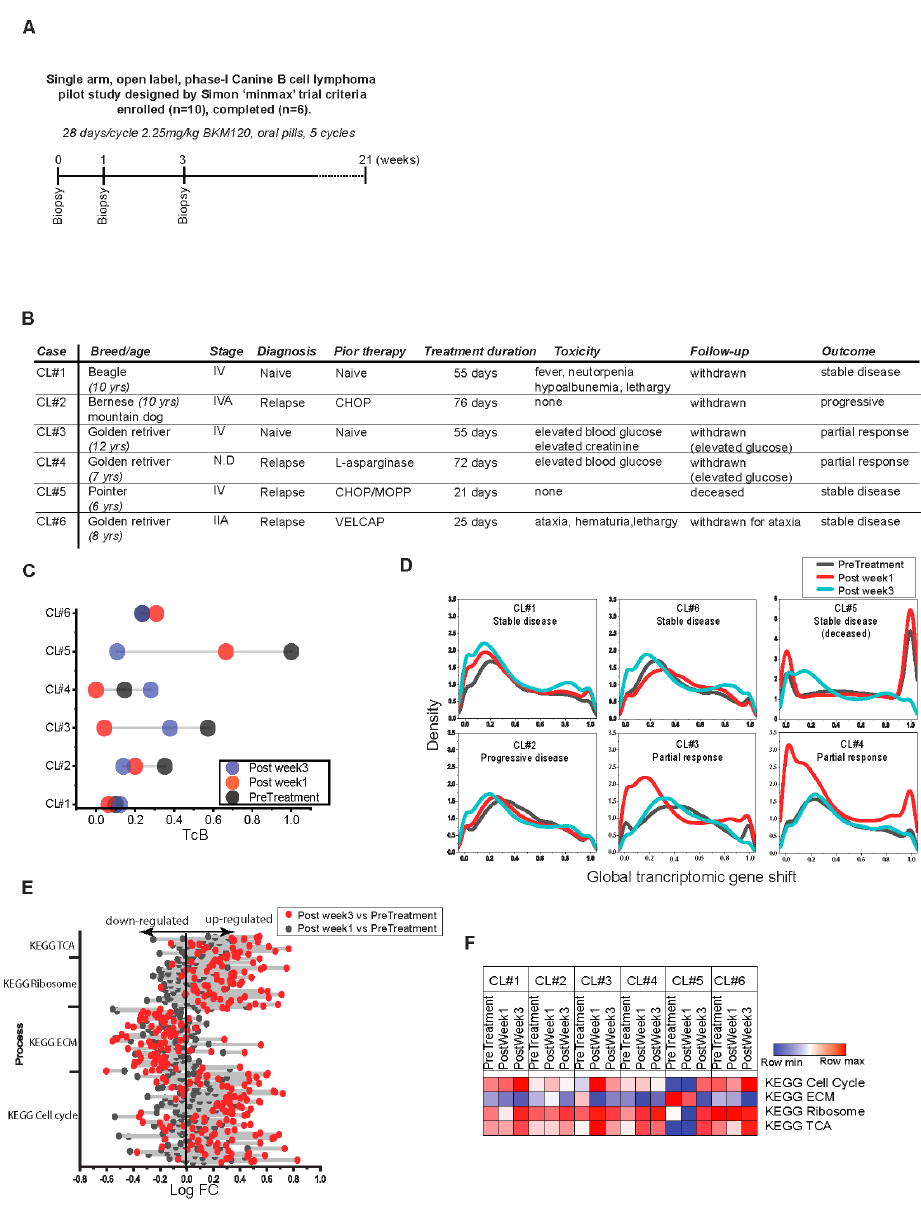
Figure 6. Targeted therapy impacts the biological trajectory of canine lymphoma. ( A ) Schematic illustration of BKM120 canine lymphoma clinical trial design. ( B ) Clinical characteristics of canine lymphoma trial subjects including clinical stage, diagnosis, prior therapies (CHOP-cyclophosphamide, hydroxydaunorubcin, oncovin/vincristine, and prednisone; MOPP-mechlorethamine hydrochloride, oncovin, adriamycin/doxorubicin, vincristine, L-asparginase), and treatment durations. ( C Lollipop plot displaying TcB change by pre-treatment and BKM120 treatment intervals on x-axis with canine lymphoma subjects on y-axis. ( D ) Kernel density plot of global genes (n = 30,311) transformed by median shift for overall gene behavior between pre-treatment and treatment intervals in x-axis indicated by each canine subject treated with BKM120 ( E ) Lollipop plot representing fold change in log 2 expression of individual genes representing higher-order biological processes (y-axis) comparing BKM120 treatment intervals vs. pre-treatment and in x-axis averaged by canine lymphoma subjects is represented in x-axis. ( F ) Heatmap represents the average log 2 expression of genes representing higher- order biological processes by individual canines at pre-treatment and BKM120 treatment